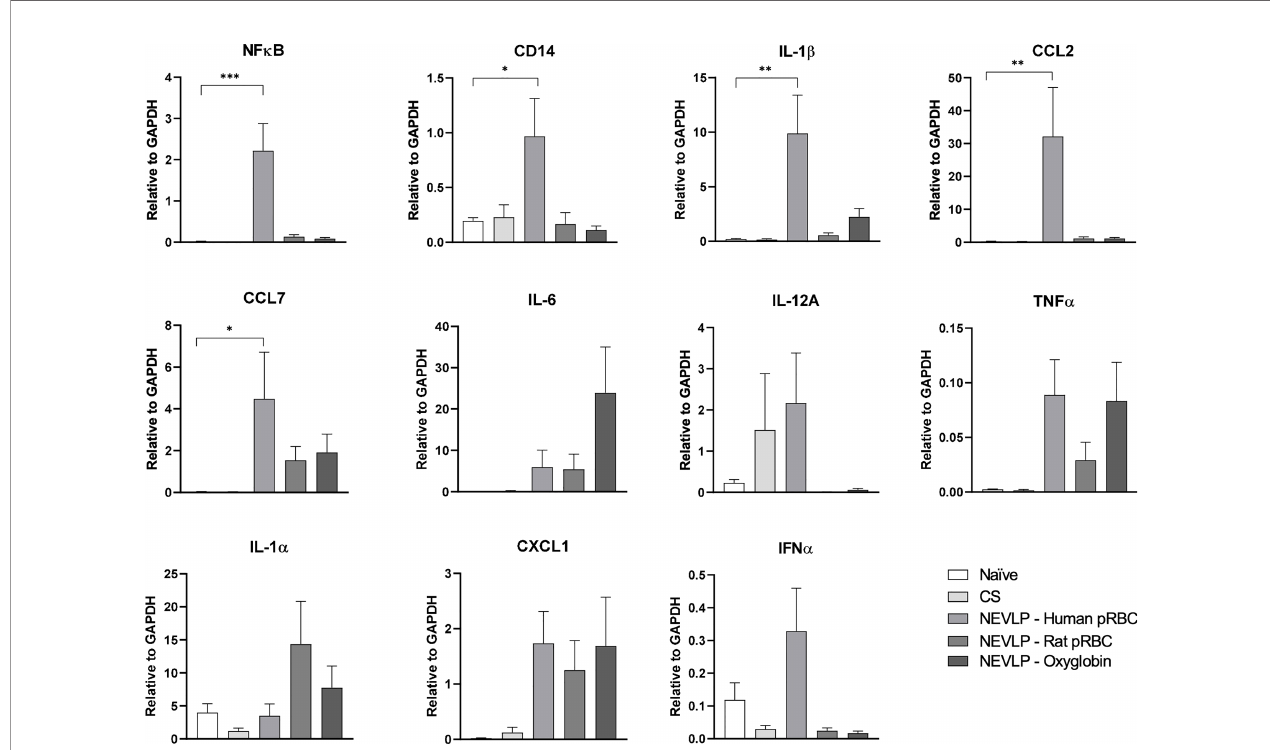
FIGURE 4 | In fl ammatory markers are elevated when using human pRBC for NEVLP. qRT-PCR was used to measure the gene expression of in fl ammatory and anti- in fl ammatory markers in NPCs. There were no signi fi cant differences in the majority of the markers assessed; however, the levels of IL-1, CCL2, CCL7, CD14, and NF- k B were higher in the human pRBC compared to those in naive. One human pRBC and one rat pRBC NEVLP experiment had poor cell yield after liver digestion and NPCs were prioritized for fl ow cytometry; therefore, data consist of naive (n = 4), SCS (n = 4), NEVLP with human pRBC (n = 5), NEVLP with rat pRBC (n = 6), and NEVLP with Oxyglobin (n = 8). *p < 0.05, **p < 0.01, ***p <